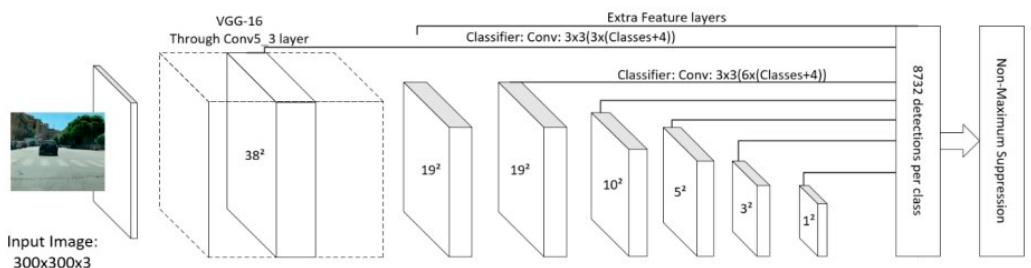
Figure 10. The architecture of SSD model.